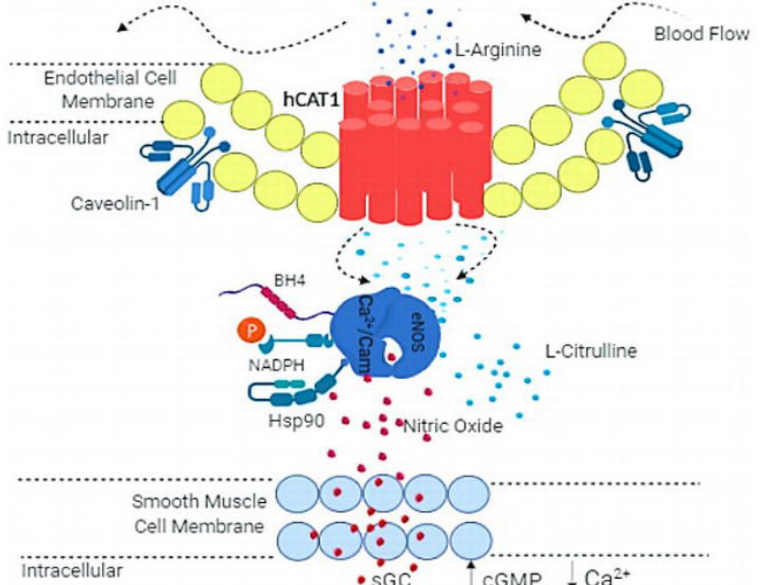
Figure 1. Nitric oxide synthesis from L-Arginine in endothelium . González & Rivas (2020) [25]. The consumption of 6 g/day L-Arg with trace amounts of vitamins and branched chained amino acids (BCAA) for three days increased plasma nitrate and nitrite [22]. In- gestion of a beverage rich in L-Arg and other AAs, including L-Cit, BCAA, and fructose, reduced the oxygen cost of moderate-intensity exercise and enhanced overall activity [22];